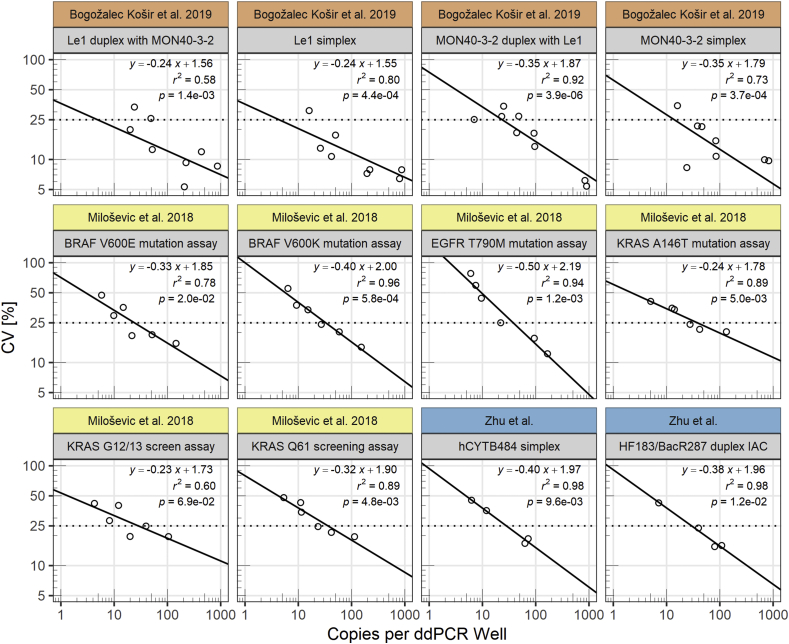
CV values plotted against copies per ddPCR well on log10-log10 axes for data obtained from this study (Zhu et al.), Bogožalec Košir et al., 2019 (Bogožalec Košir et al., 2019), and Milošević et al., (2018) (Milosevic et al., 2018). We fitted ordinary least squares linear regressions to the log10 transformed CV values and log10 transformed copies per ddPCR well. We report linear equations, r2 values, and F-statistic p-values (for the slope coefficient) displayed in top right corner of each plot and plotted a dotted horizontal line at CV = 25% to represent the aLLoQ imprecision goal. The 12 plots include both simplex and duplex assays with assay name indicated under each study label.